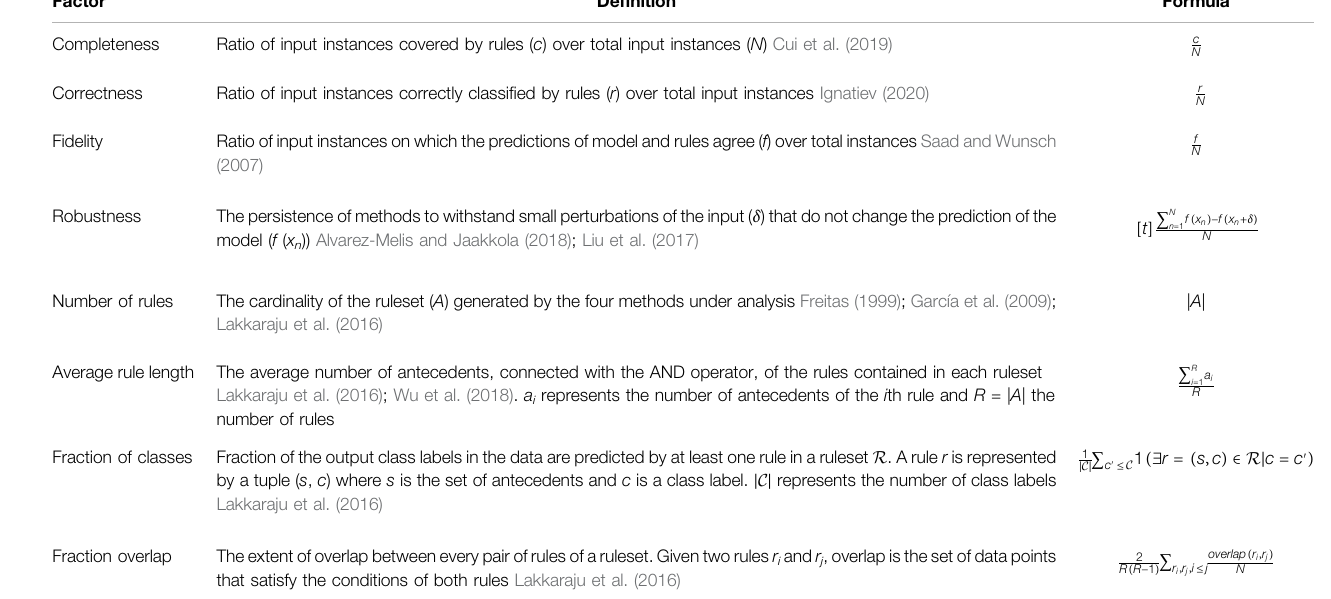
TABLE 3 | Objective metrics to assess the explainability of rulesets. Factor De fi nition Formula